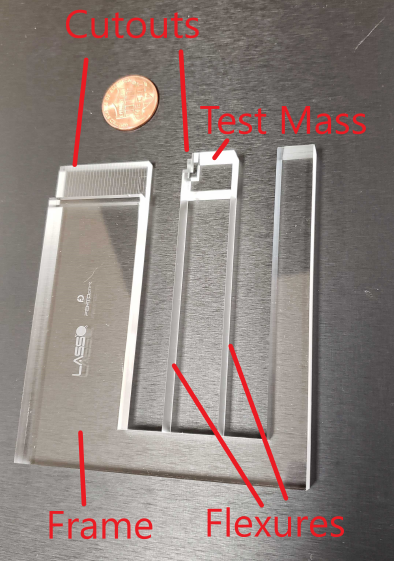
Figure 1. A diagram of our 5Hz resonator. A penny is added for